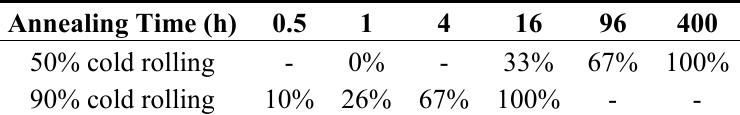
Figure 3. Recrystallization fraction during isothermal annealing for 50% and 90% cold-rolled FePd alloy at 700 °C. The solid symbol indicates the results obtained from EBSD, whereas the open symbol represents the predicted values obtained by using the JAMK equation. Table 1. Recrystallization fraction as a function of annealing time at 530 °C for 50% and 90% cold-rolled FePd